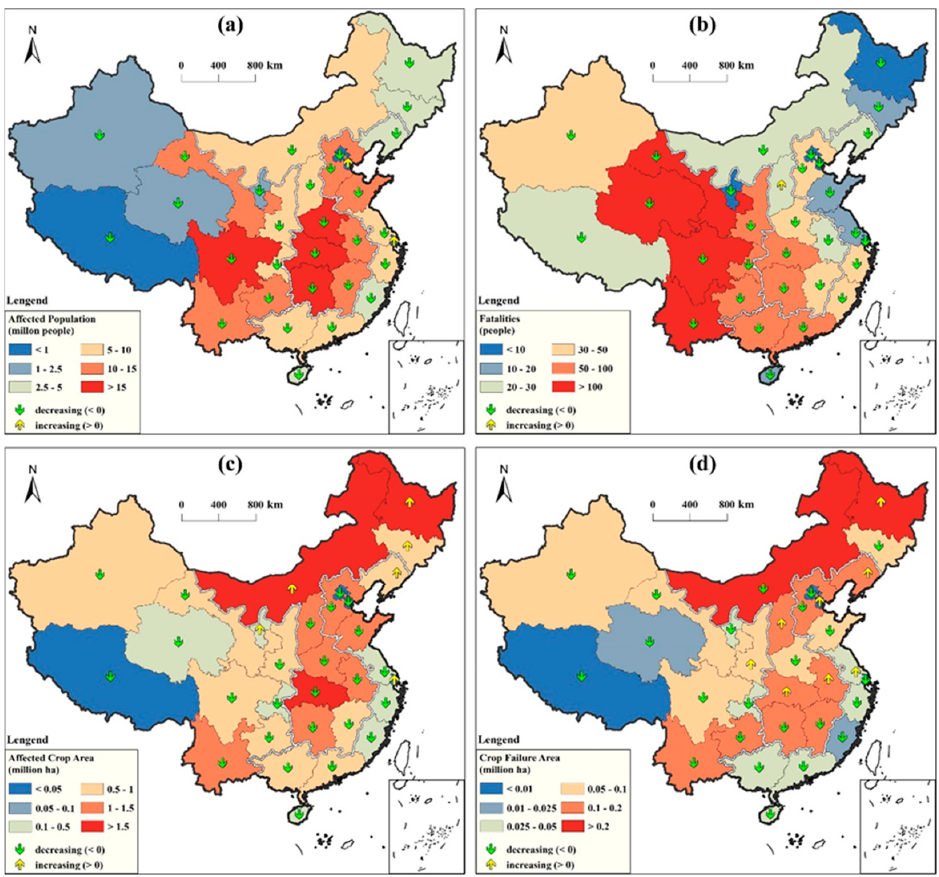
Figure 3. Spatial distributions of averages and rates of ( a ) affected population, ( b ) fatalities, ( c ) affected crop area, ( d ) crop failure area caused by natural disasters, from 2010 to 2020, in China. Moreover, natural disasters are always categorized as hydrological and geological disasters. Here, we focused on seven typical disasters (drought, earthquake, extreme temperature, flood, landslide, mass movement and storms) included in the above categories, and analyzed the losses during the study period. According to our mean statistics in the last decade, major disasters in China have affected 563.57 million people, caused 15,286 deaths, and cost 291.03 billion USD in direct economic losses. Different degrees of damage to diverse disaster-bearing bodies have been caused by various natural disasters. Droughts, floods and storms were the main natural disasters causing damage to the pop- ulation, accounting for 14.15, 70.21 and 12.66% of the total population affected by major disasters in China, respectively. In contrast, the total proportions of the affected popula- tion caused by earthquakes, extreme temperatures, landslides and mass movement were less than 3% (Figure 4). Fatalities were mainly induced by floods (accounting for 43.18%), followed by earthquakes (27.62%) and landslides (18%). Floods were the leading natural disasters causing direct economic losses, accounting for approximately 58.93% of the total, followed by storms and earthquakes at 27.8% and 7.23%, respectively. In short, floods were the leading natural disasters, causing the most severe losses in China.